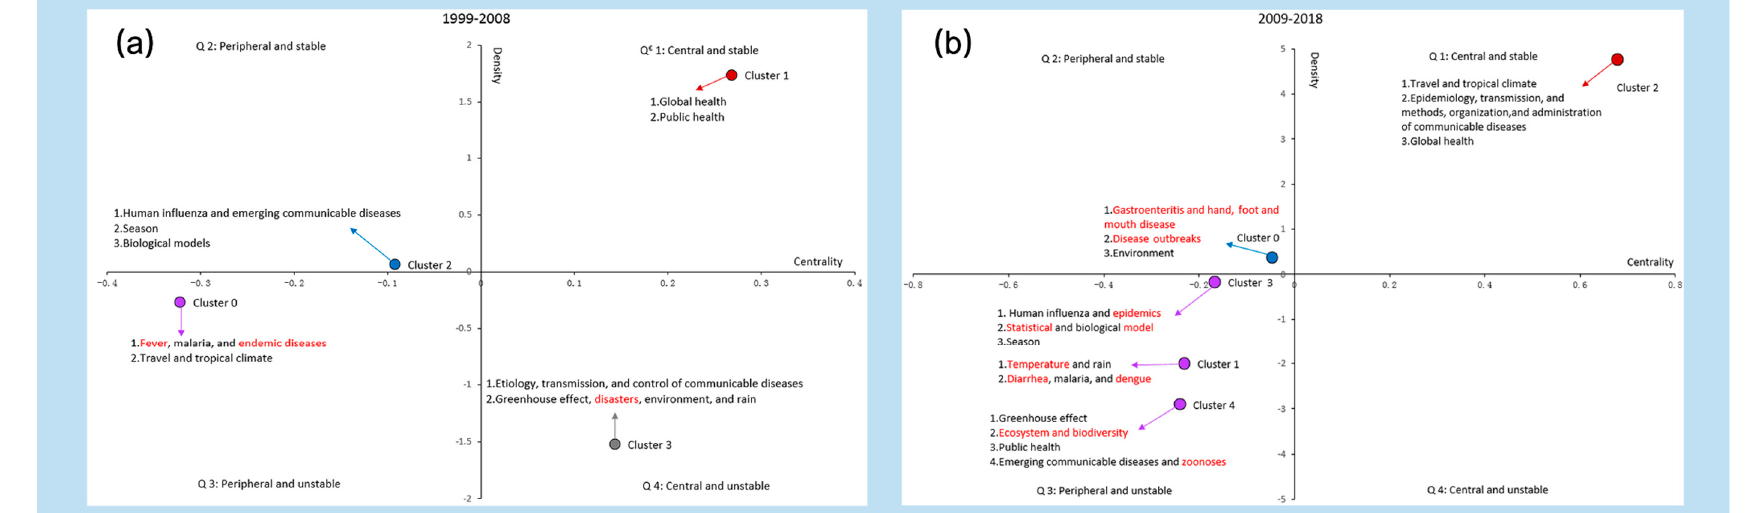
Figure 5. Strategic diagrams of hotspots in research output on climate change and infectious diseases from 1999 to 2008 and from 2009 to 2018. ( a ) Strategic diagrams of hotspot from 1999 to 2008; ( b ) strategic diagrams of hotspots from 2009 to 2018. € Q stands for quadrant. Clusters inside each strategic diagram refer to the clustering results shown in Table 2. The descriptions indicated by arrows are the hotspots of each cluster. The words in the red font represent the exclusive hotspot research topics in the first decade or the second decade.